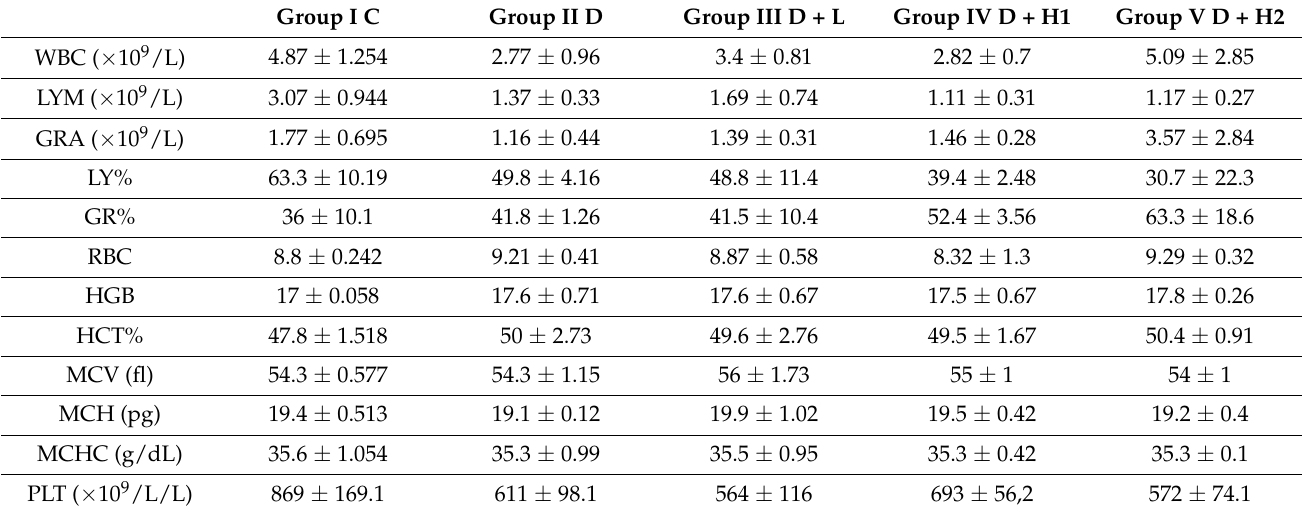
Table 2. Hematological parameters (mean values ± standard